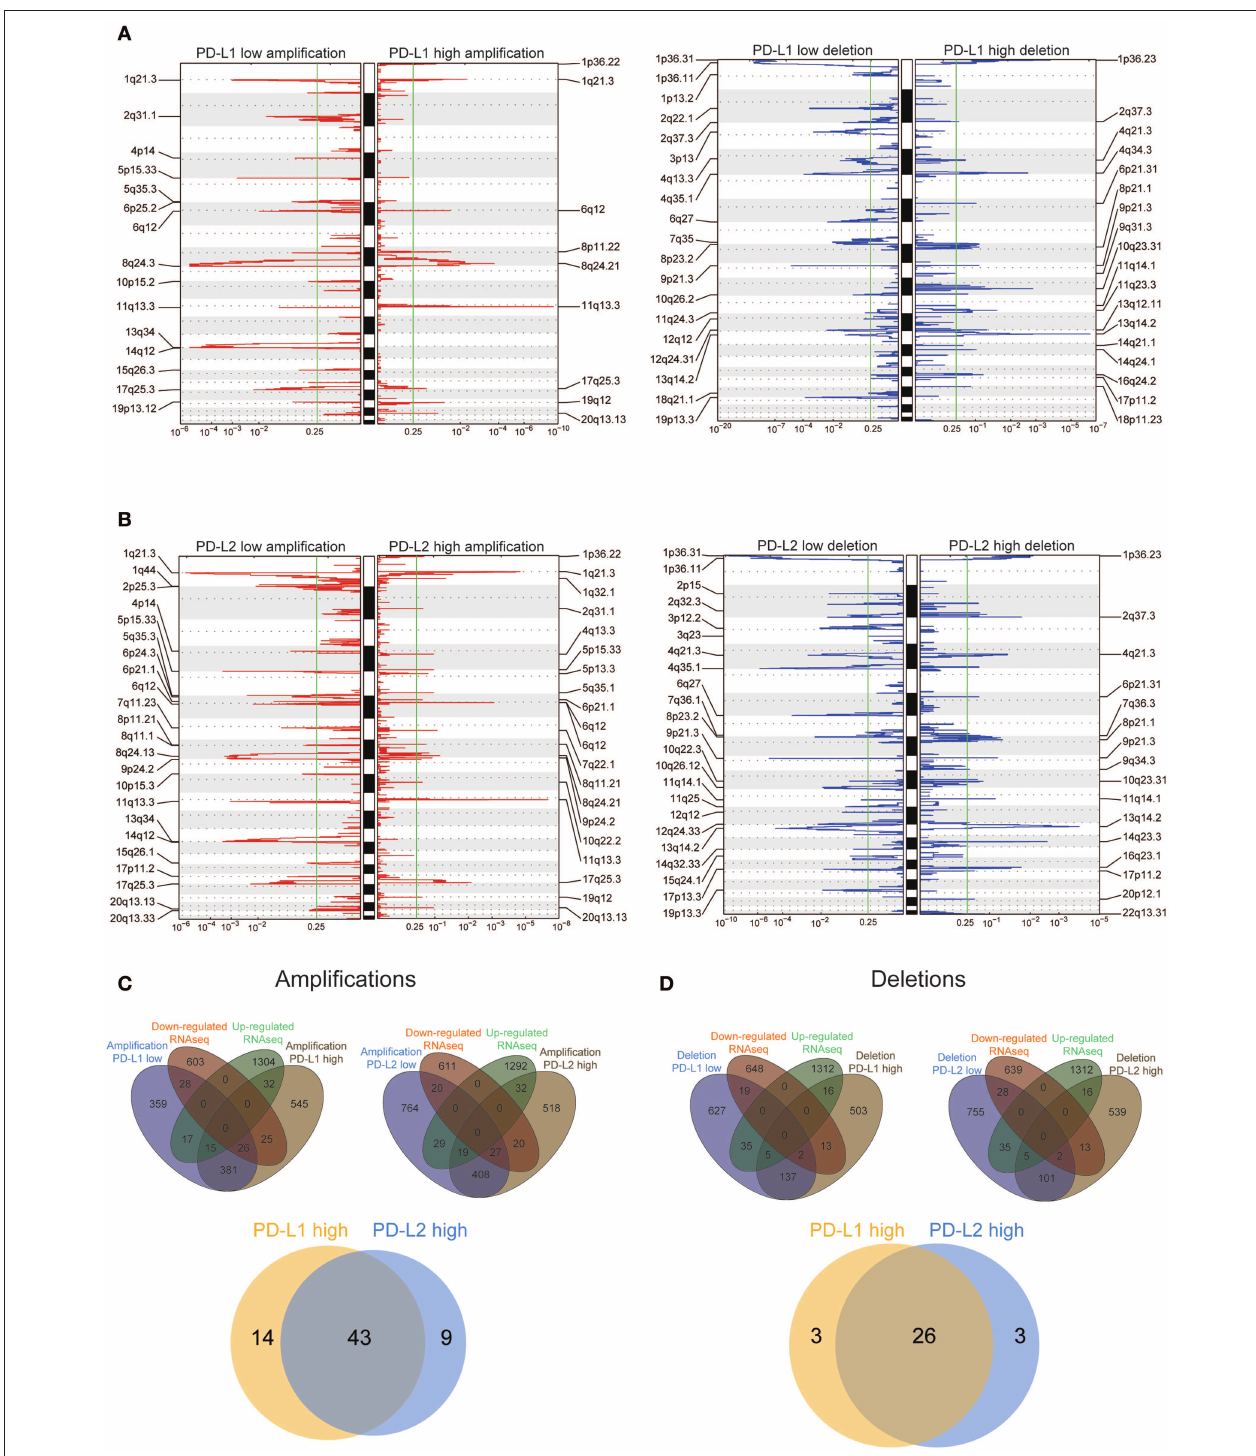
FIGURE 5 | Association between PD-Ls and CNV in HCC. (A,B) GISTIC2.0 analysis identified recurrent somatic copy number alterations in different HCC subsets stratified by PD-L1 (A) and PD-L2 (B) expression. (C,D) Venn diagrams demonstrating the number of genes within genomic regions showing significant amplification or deletion, as well as the overlay with significant genes identified from RNAseq in different HCC subsets stratified by PD-L1 (C) and PD-L2 (D) expression. Each circle in the Venn diagram represents one set and the number in the overlaid area represents the common genes between the sets.